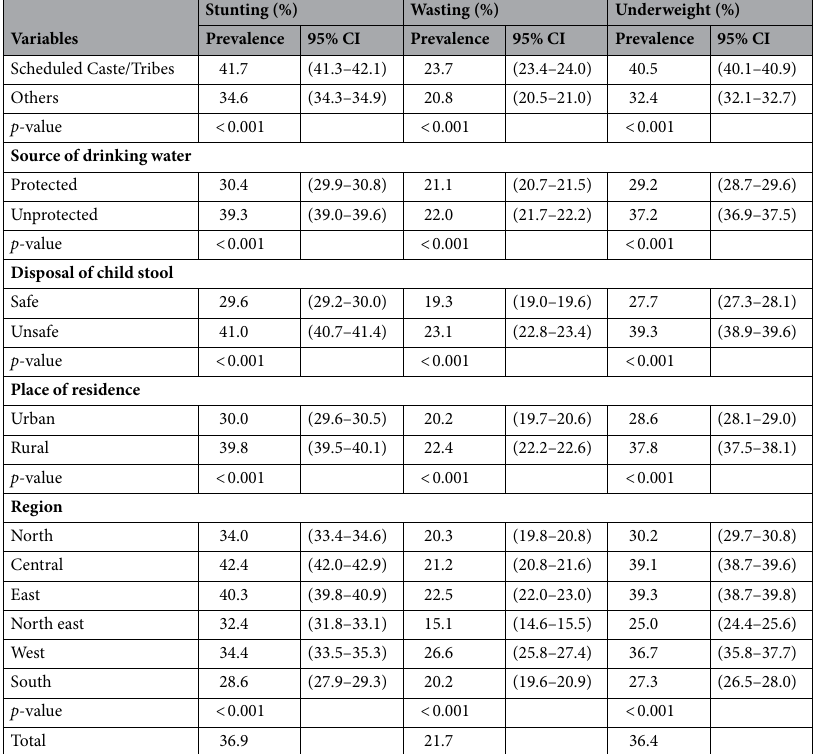
Table 2. Prevalence of children nutrition outcomes by sociodemographic characteristics and high-risk births among children aged 0–59 months, India NFHS-4. p values present the level of significance of Pearson’s chi- square